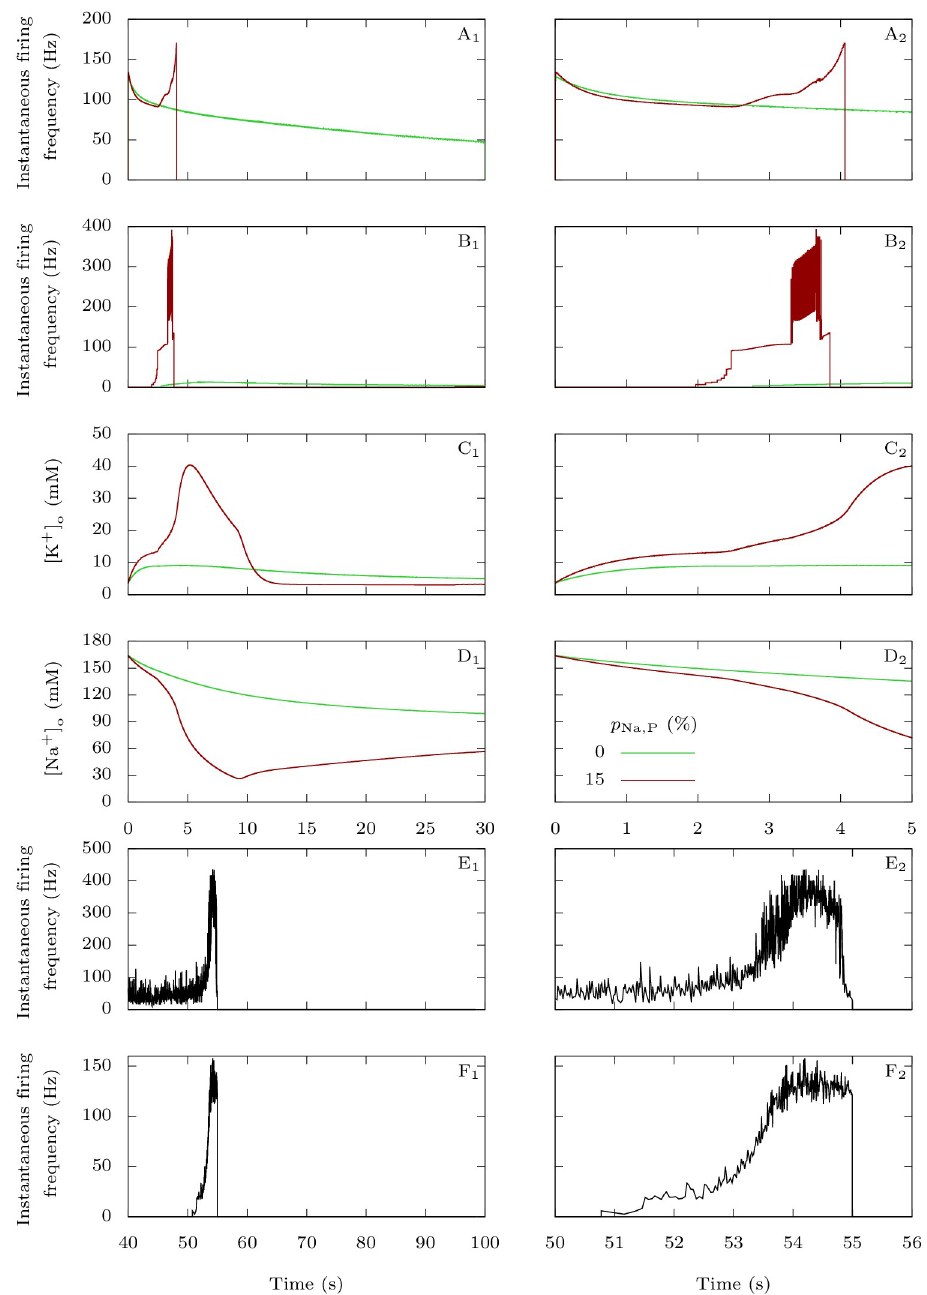
Fig 5. Behavior of the firing frequency and of the extracellular ion concentrations before the onset of CSD. A-D : Model simulations. For the first 5 s of the simulations presented in Fig 4, we compared the pathological situation ( p Na,P = 15%) with the physiological one ( p Na,P = 0%). A : Instantaneous firing frequency, i.e. inverse of the interspike interval, for the GABAergic neuron. B : Instantaneous firing frequency for the pyramidal neuron. C : Extracellular potassium concentration. D : Extracellular sodium concentration. E-F : Experimental data. E : Instantaneous firing frequency of the loose patch recording of the GABAergic neuron shown in Fig 4C 1 and 4C 3 . F : Instantaneous firing frequency of the loose patch recording of the pyramidal neuron shown in Fig 4C 2 and 4C 4 . CSD was induced by the optogenetic stimulation of the GABAergic neuron; the two phases in the firing dynamics, with lower and higher frequency respectively, are evident and similar to those observed in the simulation. Although the first phase was longer for GABAergic neurons (55.3 ± 4.5 s, n = 7) than for pyramidal neurons (1.6 ± 0.2 s, n = 5; p = 0.006 Mann-Whitney test), the second phase had similar duration (2.0 ± 0.2 s for GABAergic neurons; 1.7 ± 0.3 s for pyramidal neurons; p = 0.28, Mann-Whitney test) and firing frequency was not significantly different (mean instantaneous firing frequency in